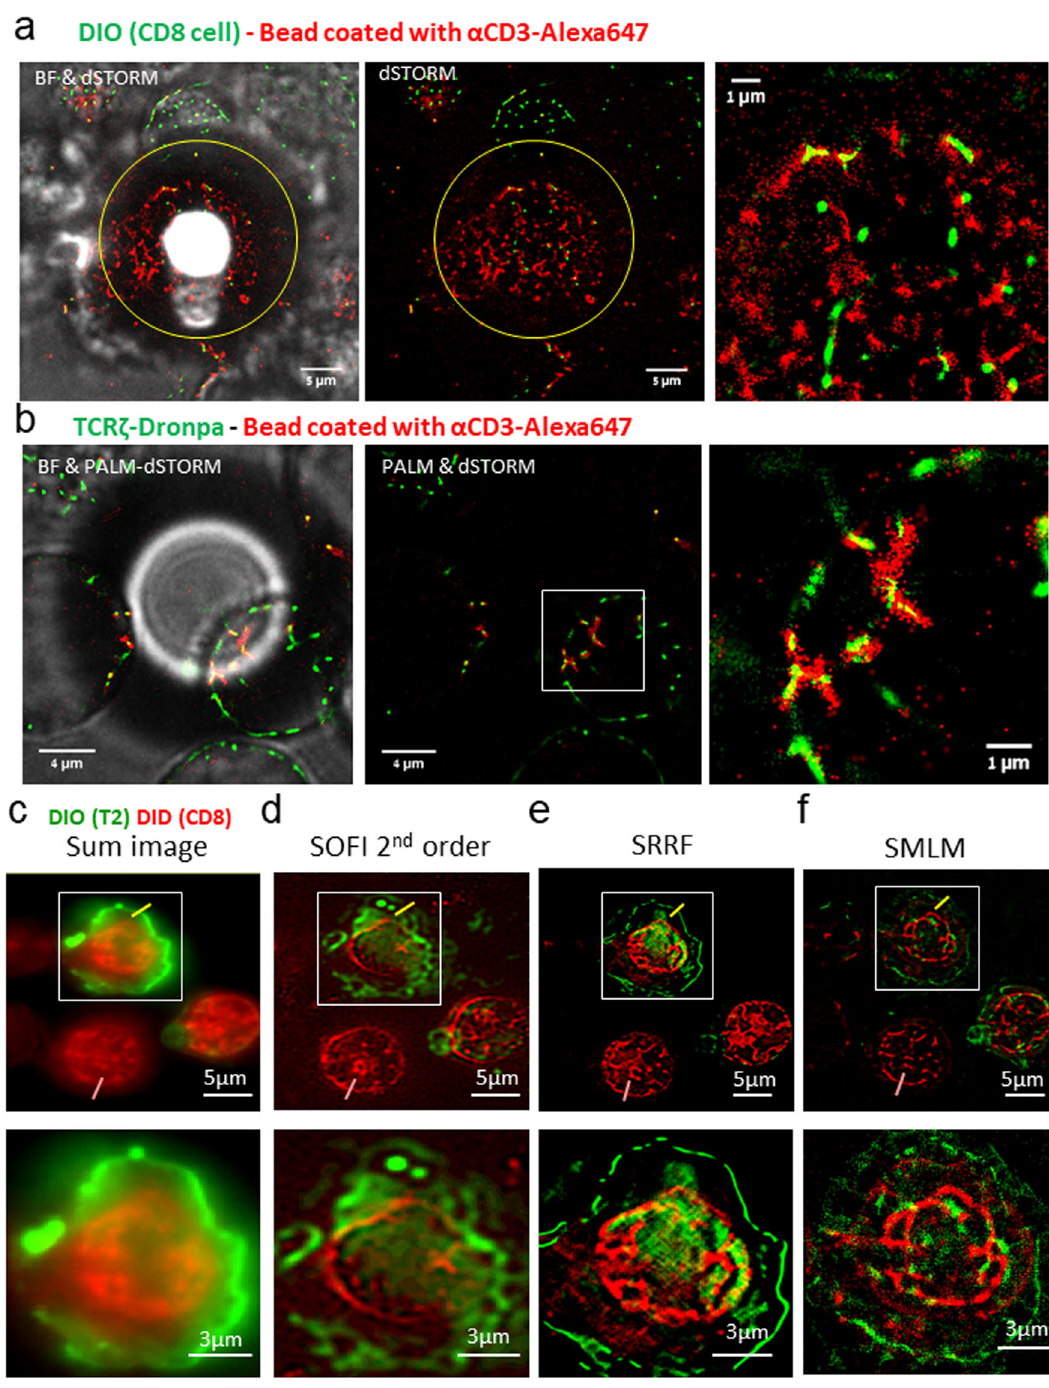
Fig. 4 Molecular organization at cell-bead interfaces and using multiple super-resolution reconstruction techniques. a The interface between 20 μ m silicon beads and CD8 + T cells. The CD8 + T cells were stained with DIO (membrane dye) and adhered to the bottom coverslip. Twenty-micrometre silicon beads (highlighted diameter in yellow circle) were coated with α CD3 ε -Alexa647, and adhered to the top coverslip. A representative cell-bead interface is shown. Bright fi eld of the cell-bead interface, merged with the two fl uorescence channels (left panel). Fluorescence imaging of DIO (green) and α CD3 ε (red) (middle panel). Zoom in on the cell-bead interface (right panel). b The interface between 20 μ m silicon beads and Jurkat E6.1 T cells. Jurkat E6.1 (CD4 + T) cells stably expressing TCR ζ -Dronpa adhered to the bottom of coverslip. On top, 20- μ m silicon beads coated with α CD3 ε -Alexa647. A representative cell-bead interface is shown. Bright fi eld merged with fl uorescence (left panel). Fluorescence of Dronpa (green) and CD3 ε (red) (middle panel). Zoom in on the cell-bead interface (right panel). c – f Super-resolution images of cell conjugates of CD8 + T cells with T2 cells loaded with the activating peptide NY- ESO-1. The PM of the CD8 + T cells was stained with DiD (red) and the PM of the T2 cells was stained with DiO (green). Reconstructions of the same cells are shown through either c Sum image (via summing the intensity of all frames), d Second-order SOFI, e SRRF, f SMLM (via the ThunderStorm software). Top images show the entire fi eld, while bottom images show a zoom on a single-cell conjugate. Yellow and pink lines in top images indicate line cross- sections along which intensity pro fi les are shown and compared in Fig. S7. See main text and methods for further details regarding the reconstruction